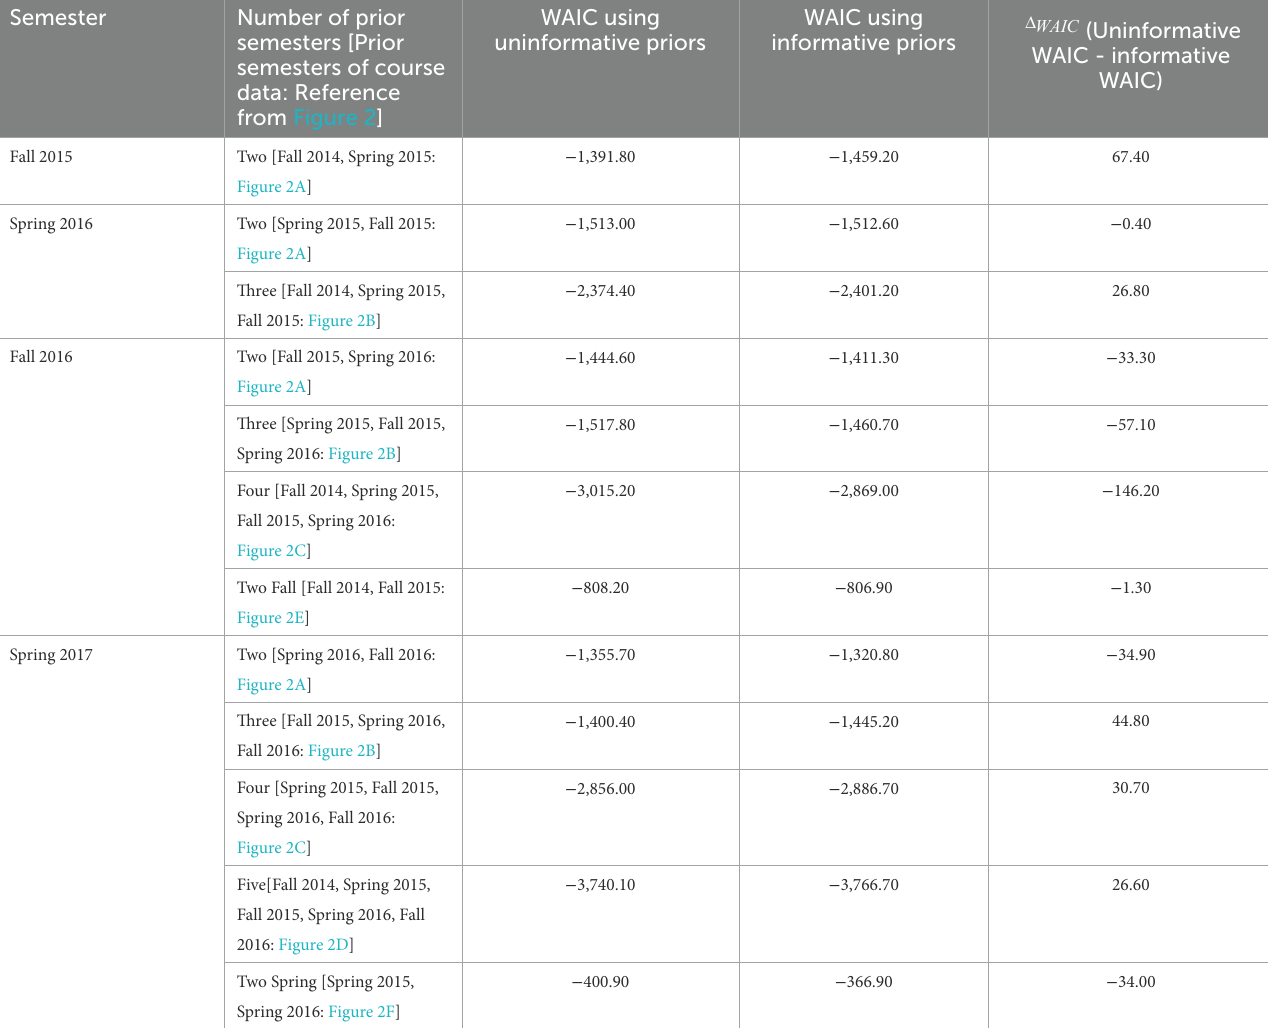
TABLE 4 WAIC results comparing Bayesian models using uninformative and informative model priors per the study design in Figure 2. Semester Number of prior semesters [Prior semesters of course data: Reference from Figure 2]